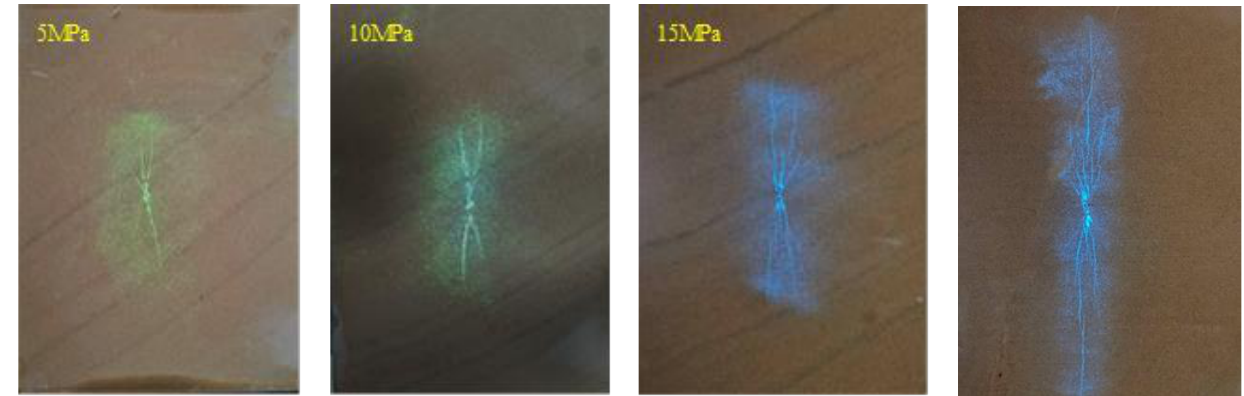
Figure 14. Crack distributions (Group I).